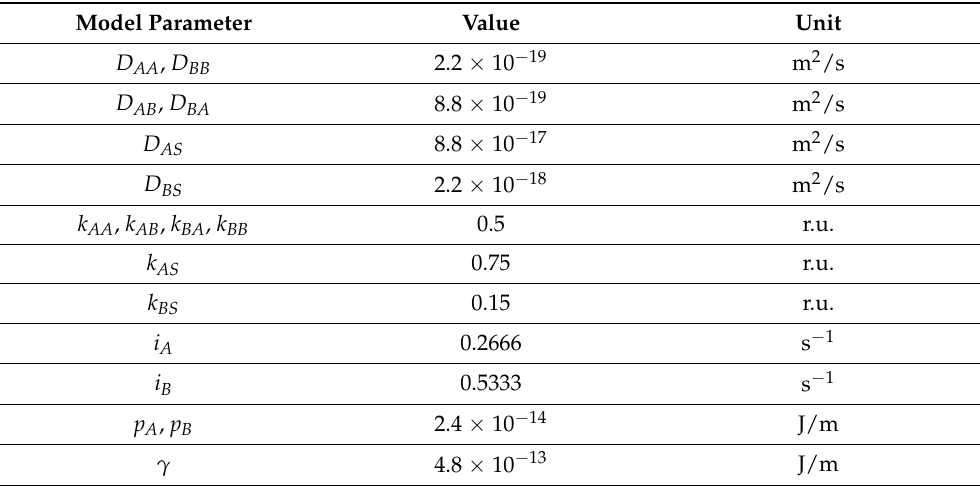
Table 1. Values of model parameters used in calculations. Model